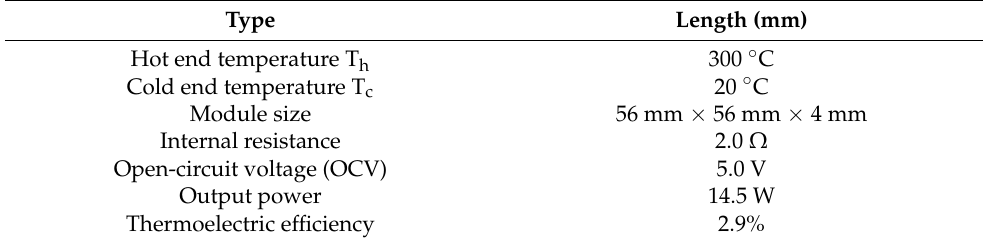
Figure 2. Prototype of thermoelectric self-cooling system. Table 1. Specific parameters of thermoelectric module.